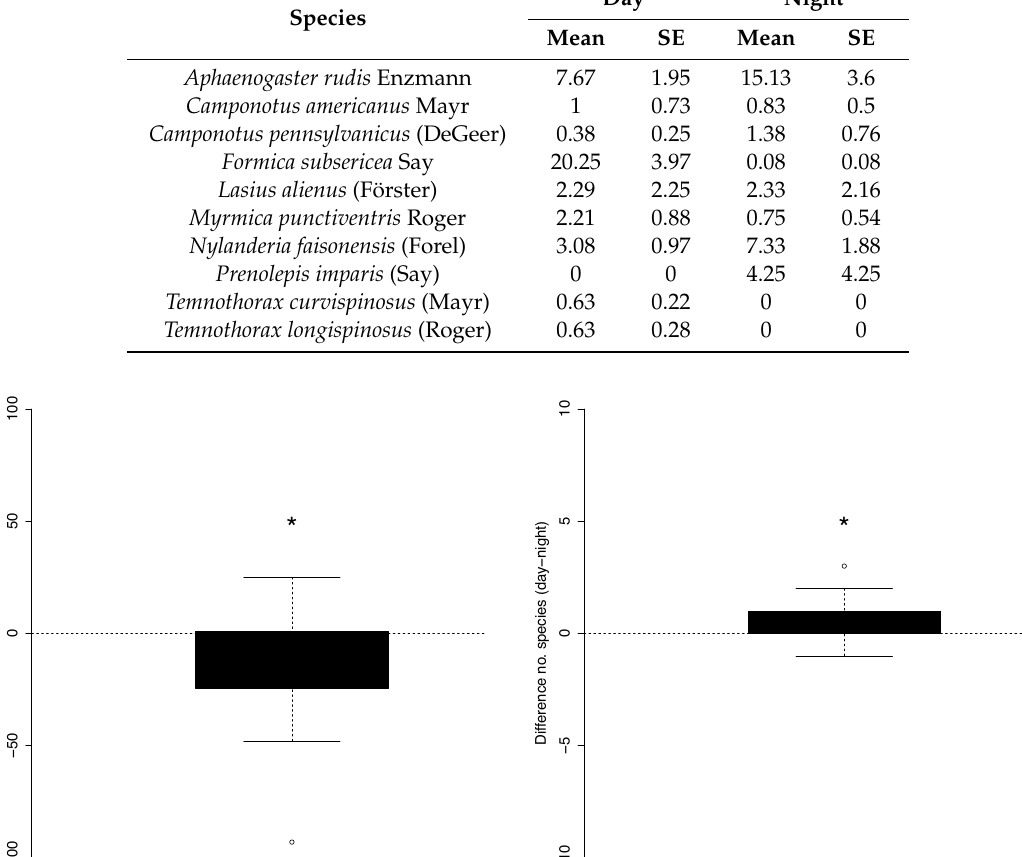
Figure 4. Mean di ff erence in the ( a ) number of workers and ( b ) species richness of non-dominant ant species recorded on baits during day and night. Asterisk indicates a significant di ff erence in foraging activity between day and night ( p <